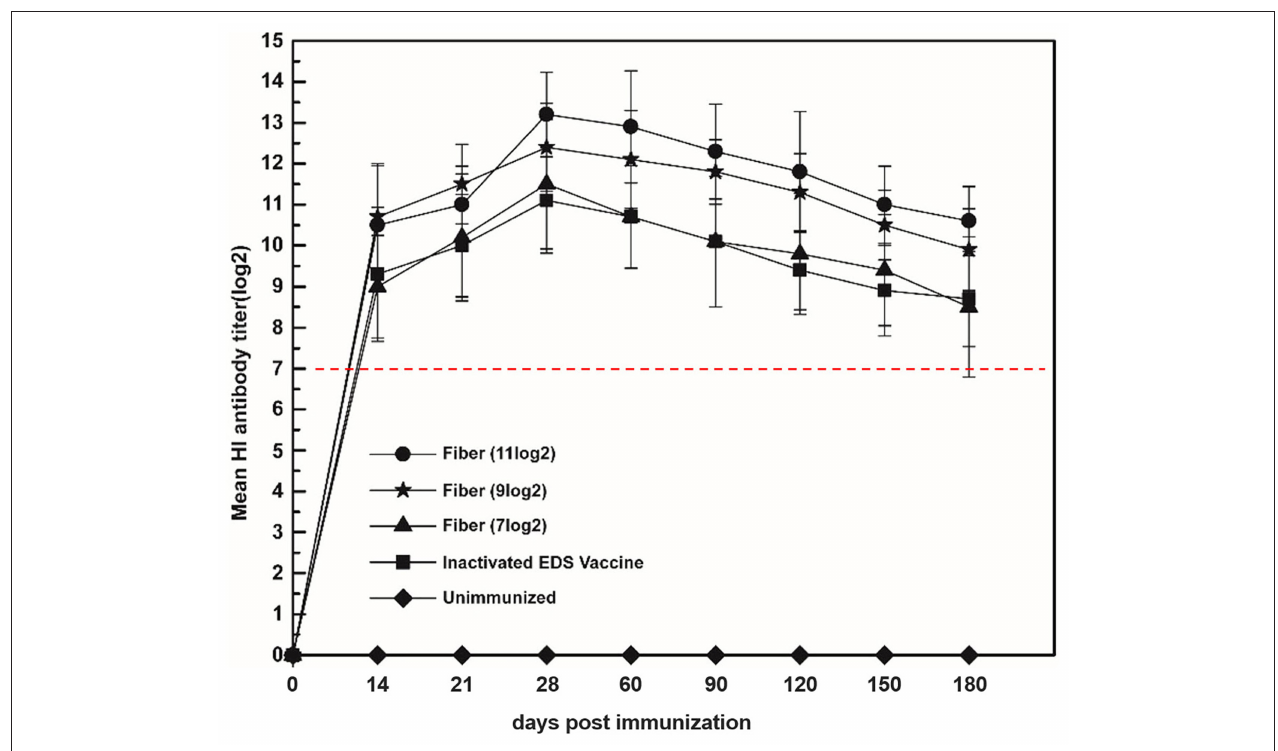
FIGURE 4 | Correlation between fiber protein and HI titer induced by subunit vaccine. Laying hens were immunized with fiber protein at the HA titers of 11, 9, and 7 log2, respectively. The HI titers of the serum samples collected at 14, 21, 28, 60, 90, 120, 150, and 180 dpi were tested. The group immunized with the inactivated EDS vaccine was set as the positive